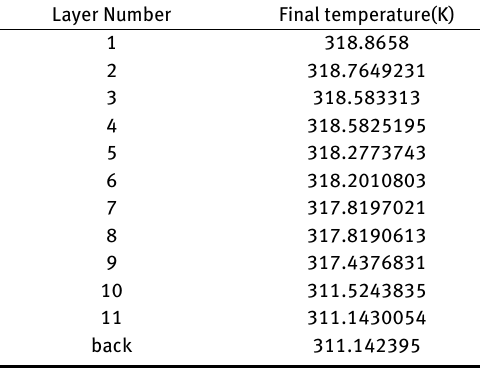
Table 5. Temperature error values during six tests